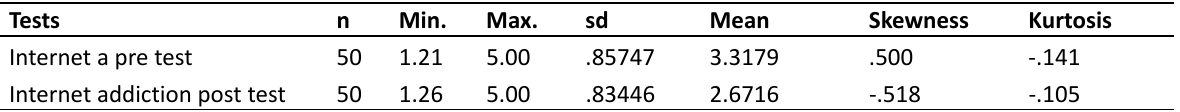
Table 2. Normality test of data Tests